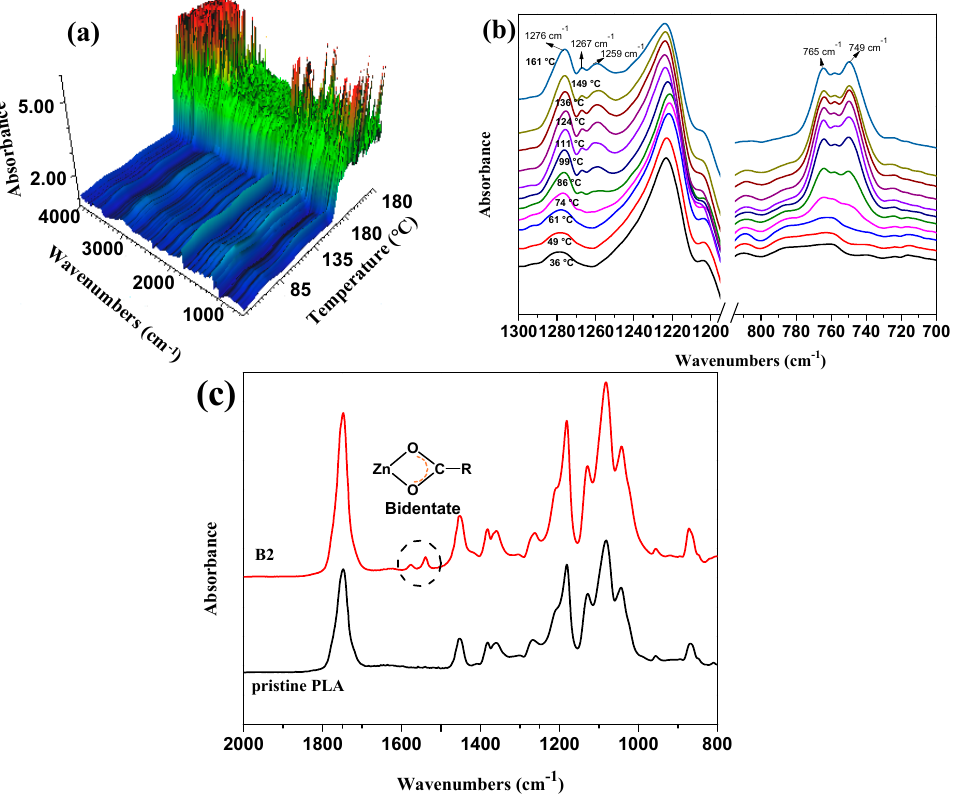
Figure 4. ( a ) 3D image of in situ FTIR of PLA/TMPTA/nano-ZnO blend; ( b ) in situ FTIR bands in the range of 1300–700 cm − 1 at different temperatures before melting; and ( c ) ATR FTIR curves of purified Sample B2 and pristine PLA.